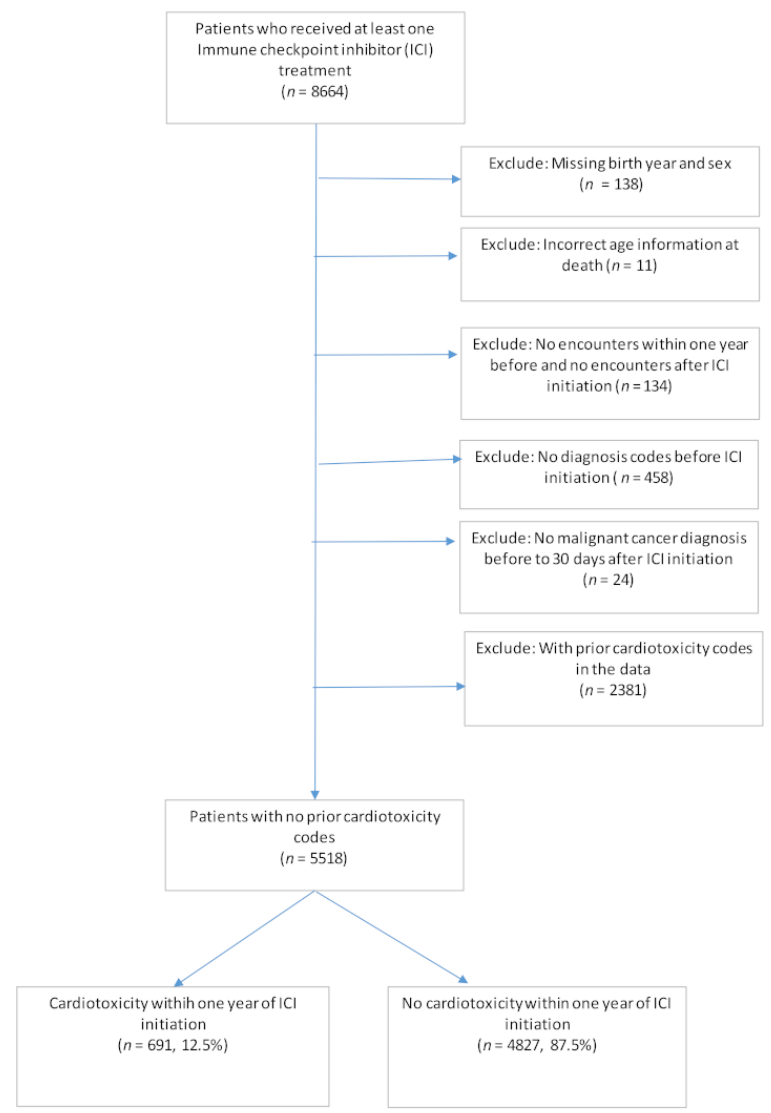
Figure 1. Patient selection